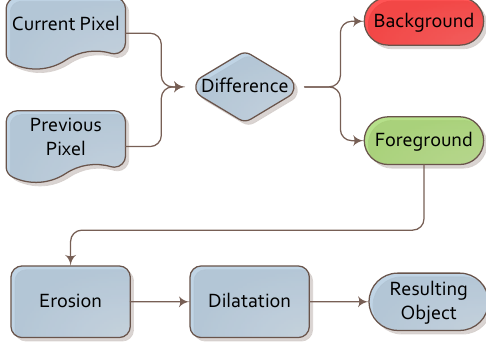
Figure 4. Algorithm for background